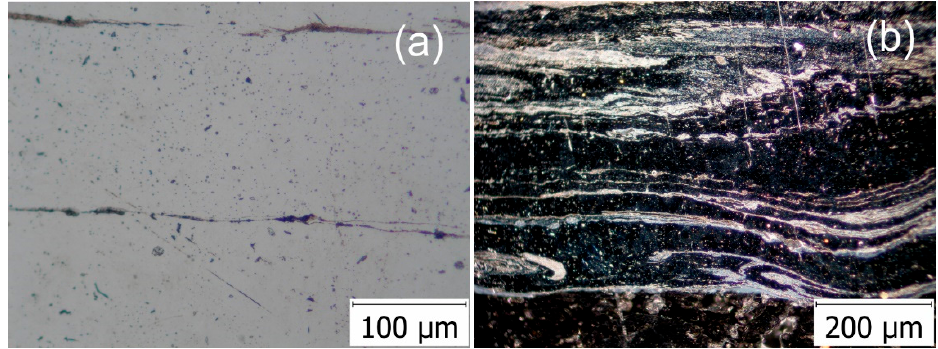
Figure 2. Optical micrograph of Ni 50.3 Ti/Ni 49.6 Ti composite discs: ( a ) bright field image of three layers and ( b ) dark field image of 24 layers.